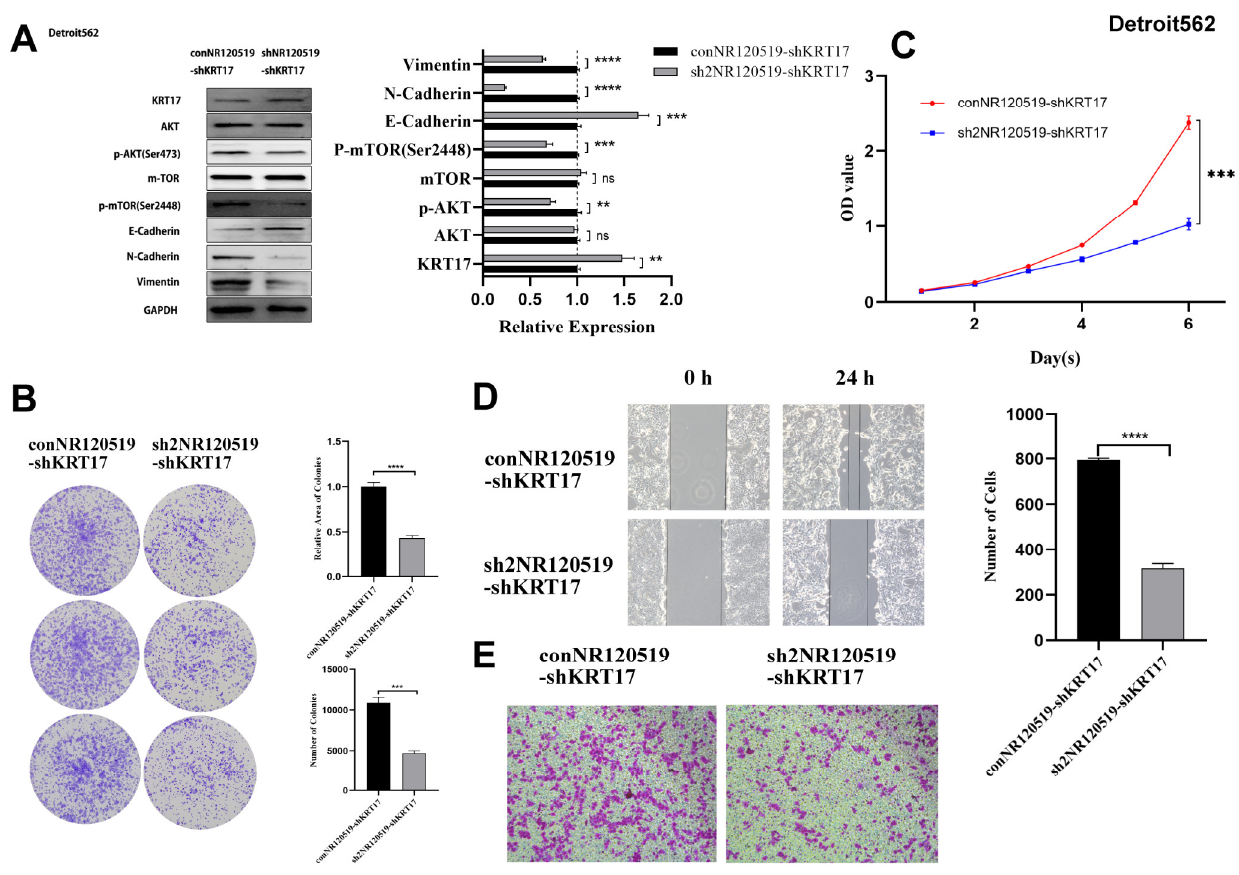
Figure 9. NR120519 knock down in Detroit562 cell line. ( A ) Western blotting showed that compared with the control group, the expression of KRT17 was increased 1.48 ± 0.12 times after NR120519 gene knockout, the phosphorylation of AKT and mTOR was significantly decreased, and the expression of E-cadherin was up-regulated. The expressions of N-cadherin and VIM were down-regulated. ( B ) Colony formation experiment showed that the number and relative area of colonies were significantly reduced after knocking down NR120519. ( C ) CCK-8 assay showed that knockdown of NR120519 delayed cell proliferation. ( D , E ) Wound-healing and Transwell assays showed that knock- down of NR120519 significantly reduced cell migration. The figures were captured under 10 × 10 microscope. ** p < 0.01; *** p < 0.001; **** p < 0.0001; ns no significance. The uncropped bolts are shown in Supplementary Materials File